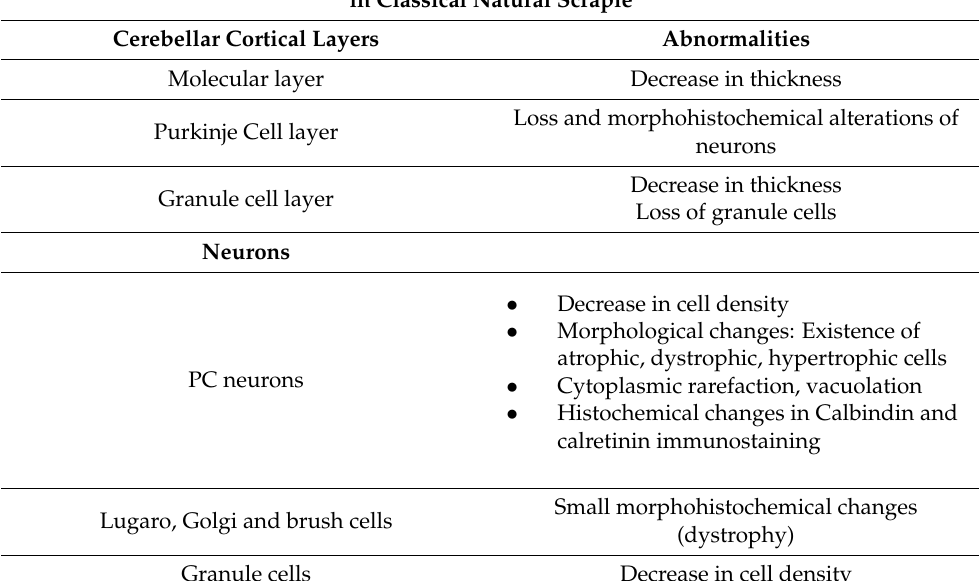
Table 1. Cerebellar neuropathological abnormalities in classical natural scrapie considered in this review (Section 3) and reflections on these studies on cerebellar neuropathological alterations in classical scrapie (Section